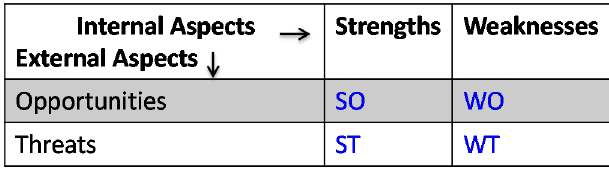
Figure 2. The SWOT